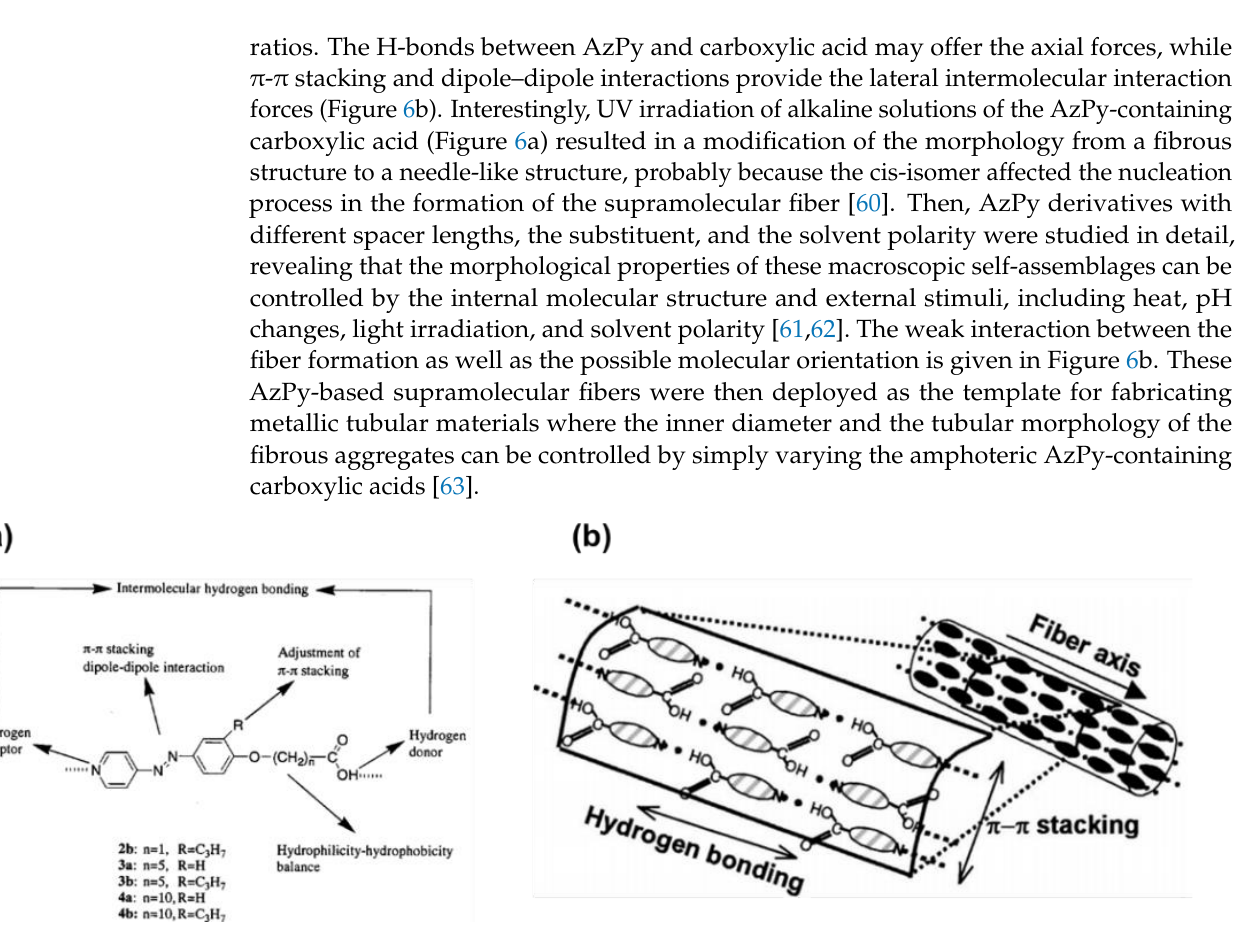
Figure 6. ( a ) Head-to-tail coupled and hydrogen-bonded azopyridine derivatives. ( b ) Schematic representation of molecular assemblages formed from azopyridine carboxylic acids. Reprinted with permission from [60]. Copyright 2011, American Chemical Society.